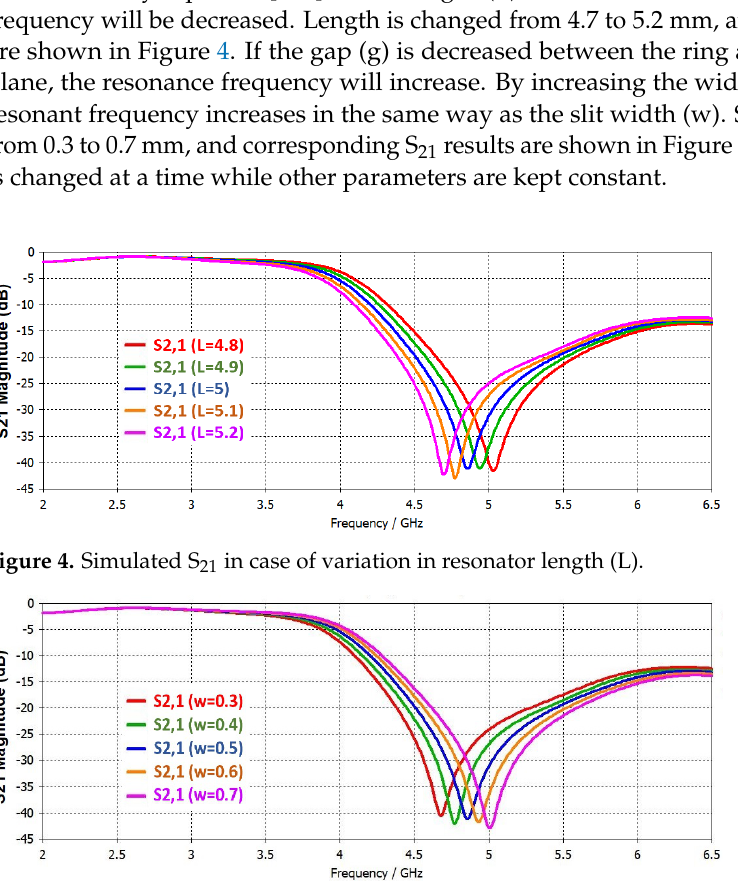
Figure 5. Simulated S 21 in case of variation in slit width